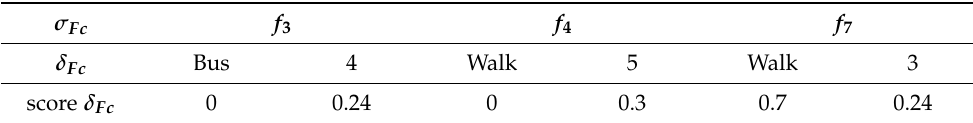
Table 6. Scores for the sub-sequence σ Fc